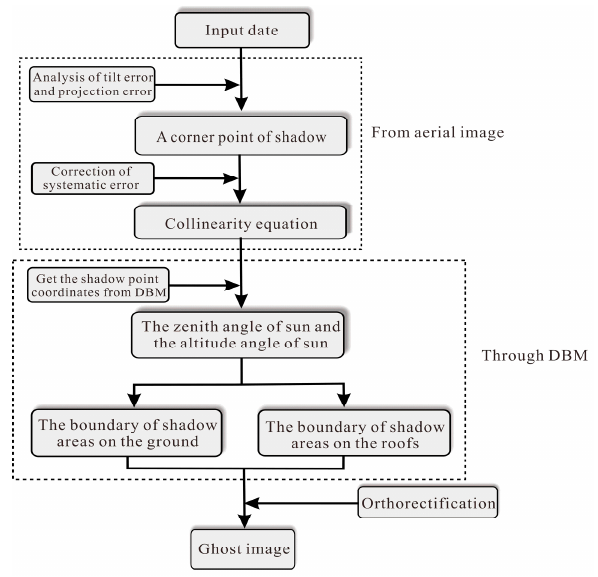
Figure 4. The flow chart of the shadow detection.